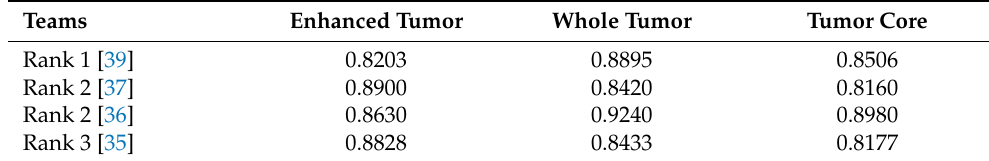
Table 11. Winning Teams’ Dice Scores.